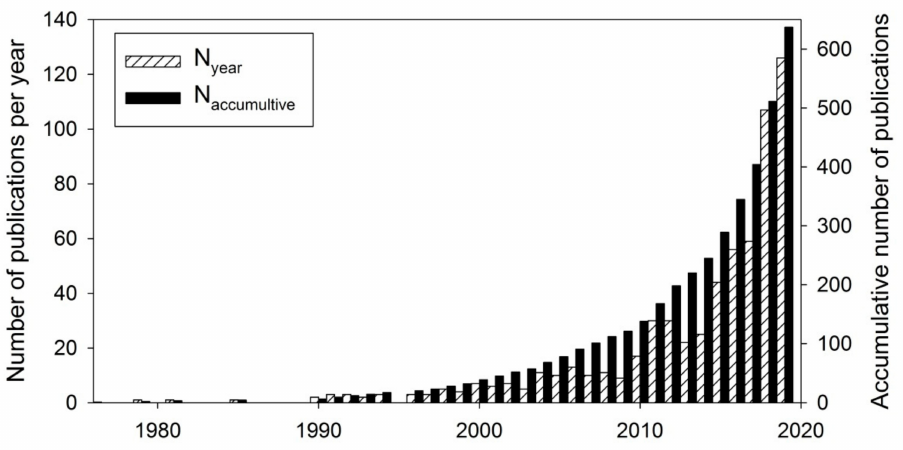
Figure 1. Increase in the number of publications dealing with liquid–liquid phase separation in protein solutions: Number of publications per annum (white crossed bars); accumulative number of publications (black bars). Data are based on the results of a PubMed search on August 19, 2019, using the search terms “liquid-liquid phase separation” and